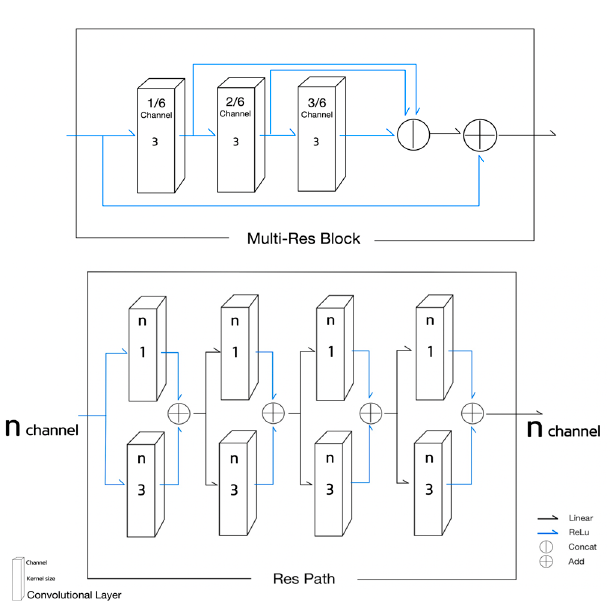
Figure 3. MultiResUNet.